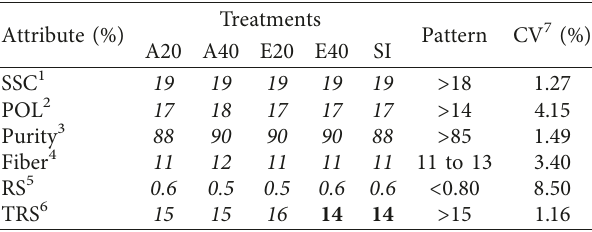
Table 6: Technological analysis compared to the standard [32] in the first ratoon